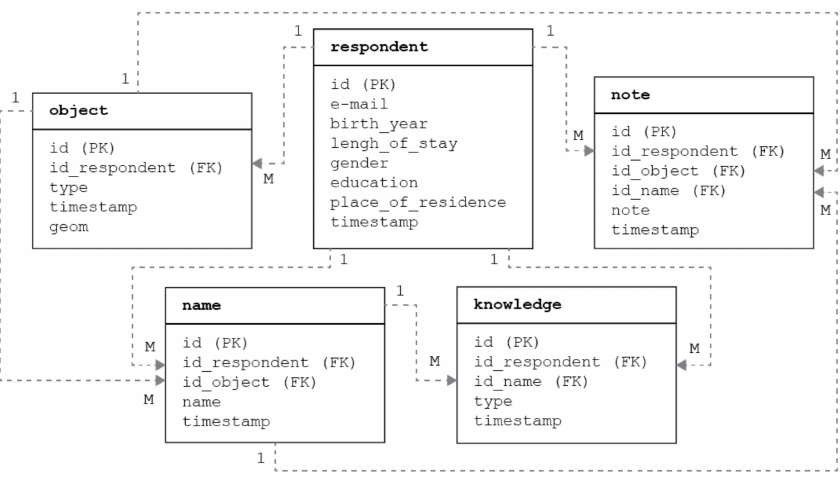
Figure 1. The general structure of the database in the Living Names